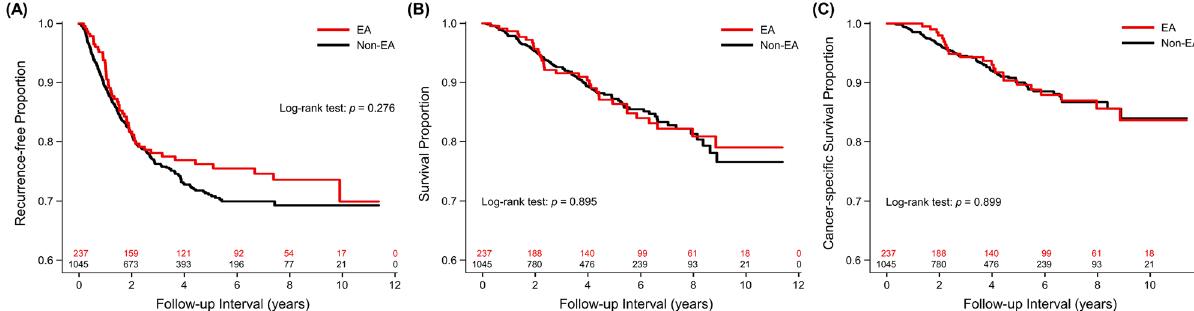
Figure 2. Kaplan–Meier curves for ( A ) recurrence-free survival, ( B ) overall survival, and ( C ) cancer-specific survival of epidural and non-epidural groups with number of subjects at